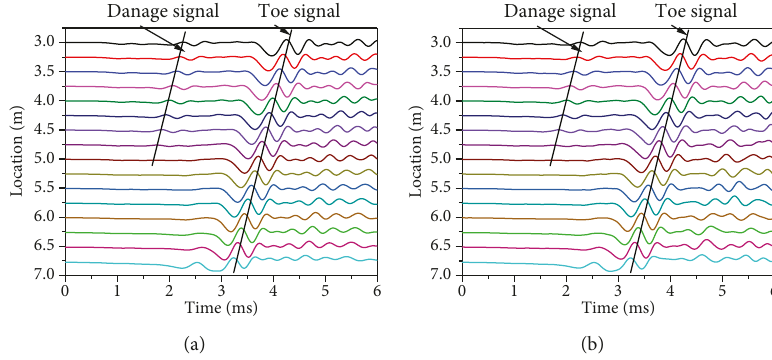
Figure 15: Upward velocity data. (a) Velocity data at A